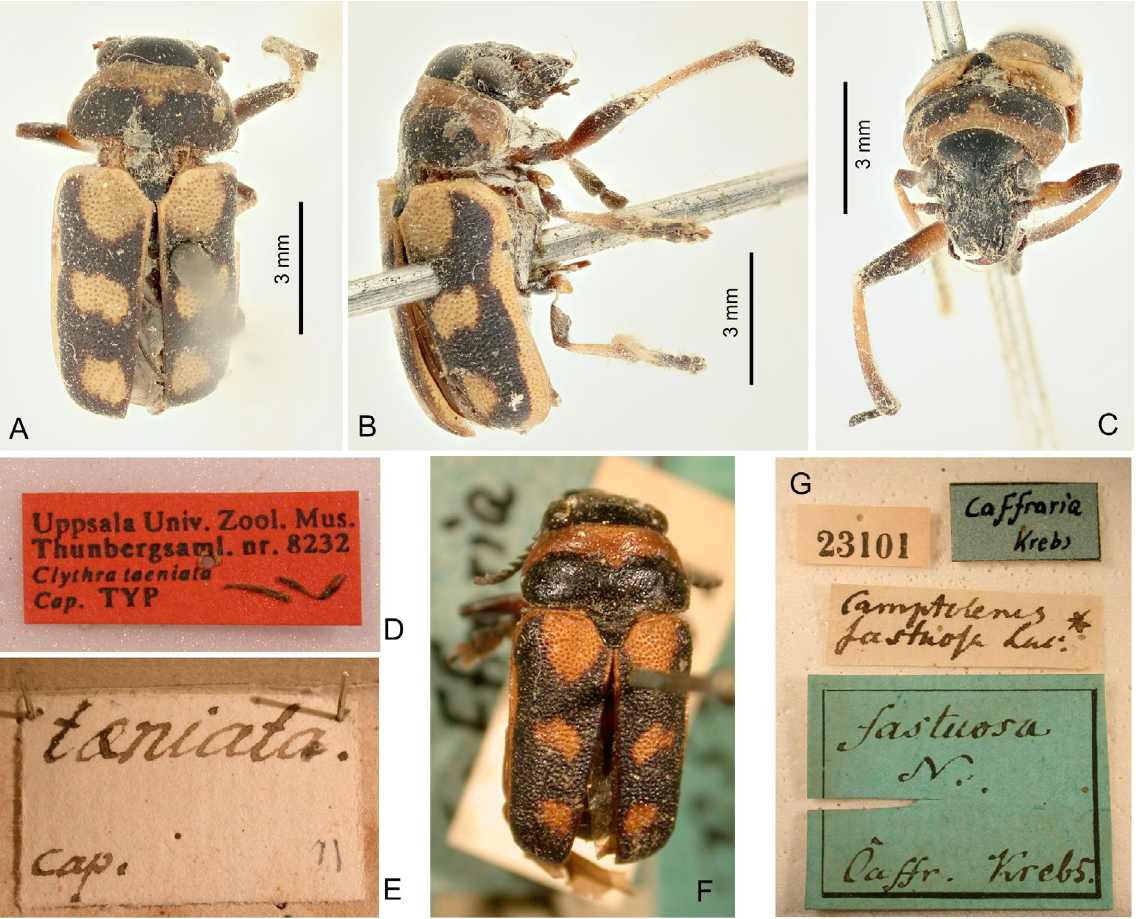
Fig. 11. Protoclytra taeniata (Thunberg, 1821) comb. nov. A–E . Holotype, ♂, 8.0 mm, UUZM. A . Dorsal view. B . Lateral view. C . Frontal view. D . Label. E . Box label. F–G . Syntype of Clythra fastuosa Lacordaire, 1848, ♂, not measured, ZMHB. F . Dorsal view. G .